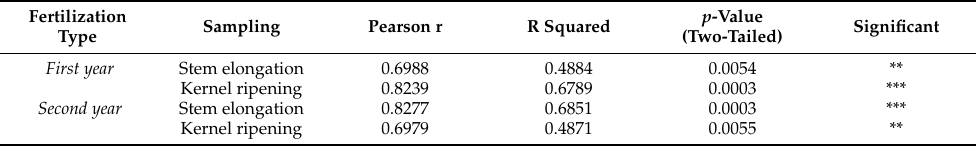
Table 5. Results of SPAD and Chl (a + b) correlation analyses. Data are based on Pearson correlation calculations using a two-tailed p -value.